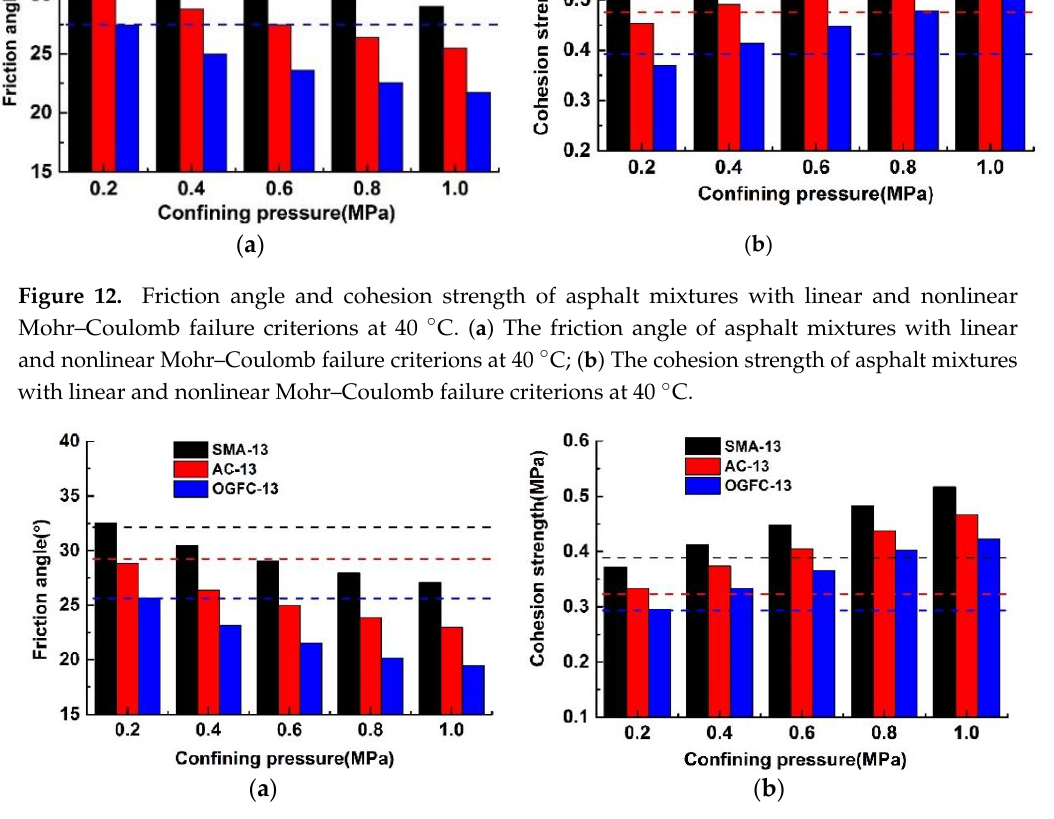
Figure 13. Friction angle and cohesion strength of asphalt mixtures with linear and nonlinear Mohr – Coulomb failure criterions at 50 °C. ( a ) The friction angle of asphalt mixtures with linear and nonlinear Mohr – Coulomb failure criterions at 50 °C; ( b ) The cohesion strength of asphalt mixtures with linear and nonlinear Mohr – Coulomb failure criterions at 50 °C.